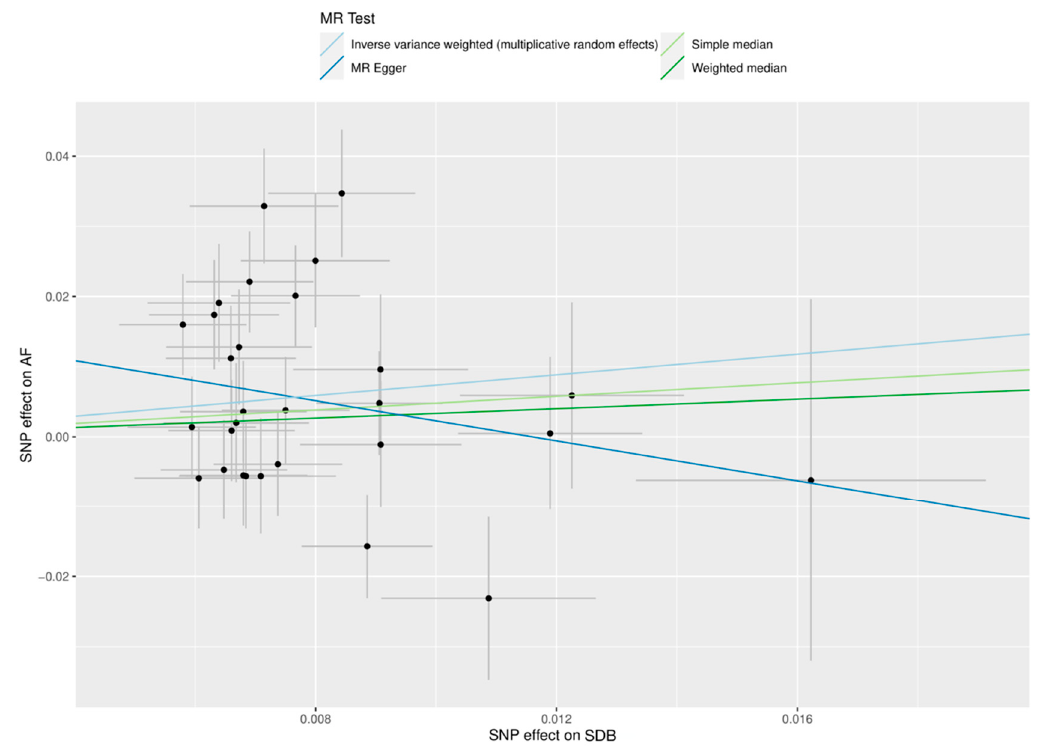
Figure 3. Mendelian randomisation (MR) scatter plot of genetic associations between sleep-disordered breathing (SDB) and atrial fibrillation (AF). The genetic association and corresponding 95% confidence interval (CI) for each instrumented single-nucleotide polymorphism ( n = 29) with SDB (x-axis, units of log odds ratio snoring liability) and AF (y-axis, units of log odds ratio atrial fibrillation liability) are plotted. The gradient of each line represents the MR estimate for the corresponding model.